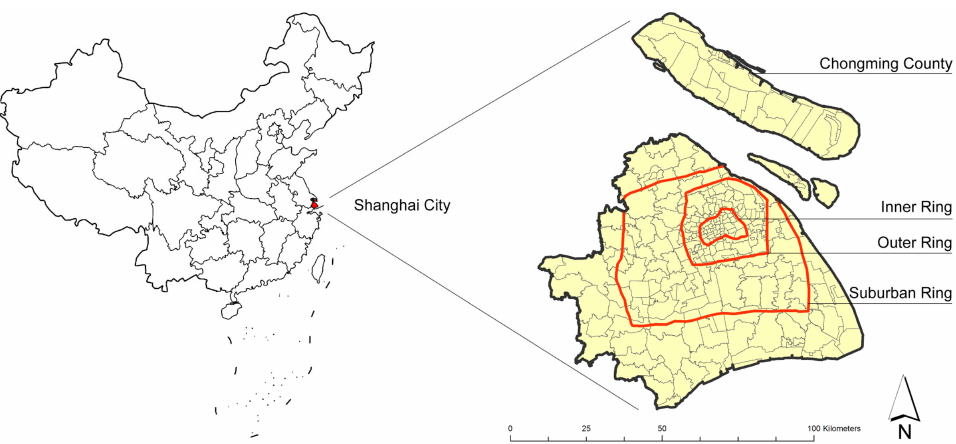
Figure 1. The location of the study site.